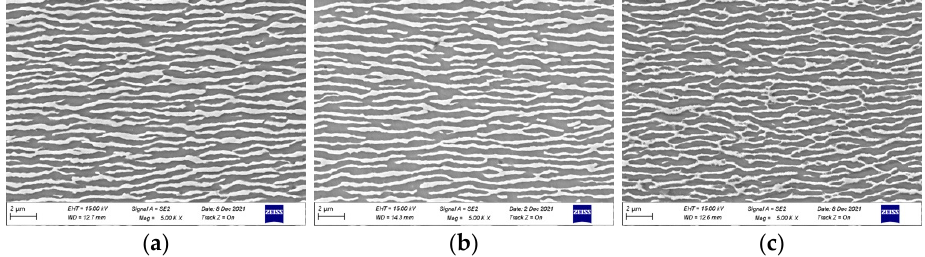
Figure 9. Microstructure 1.5 cm from the fracture surface of the ruptured samples at 1140 °C/137 MPa (126.2 h): ( a ) 6% Co; ( b ) 9% Co and ( c ) 12% Co.